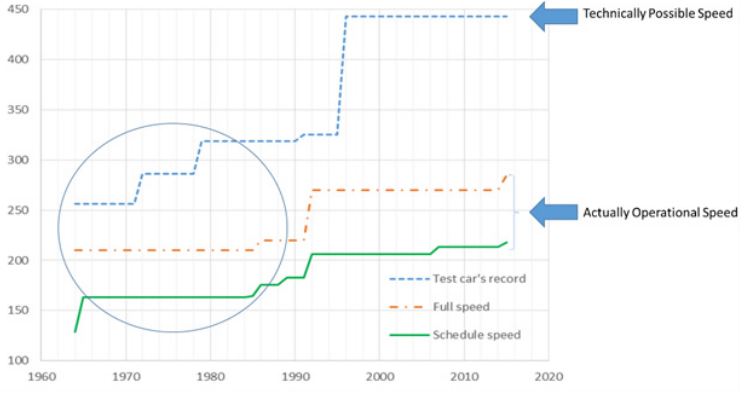
Figure 1. Transition of